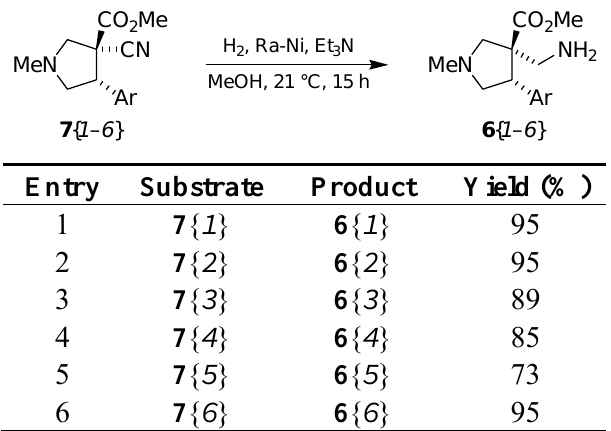
Figure 3. Amide 12 formed.